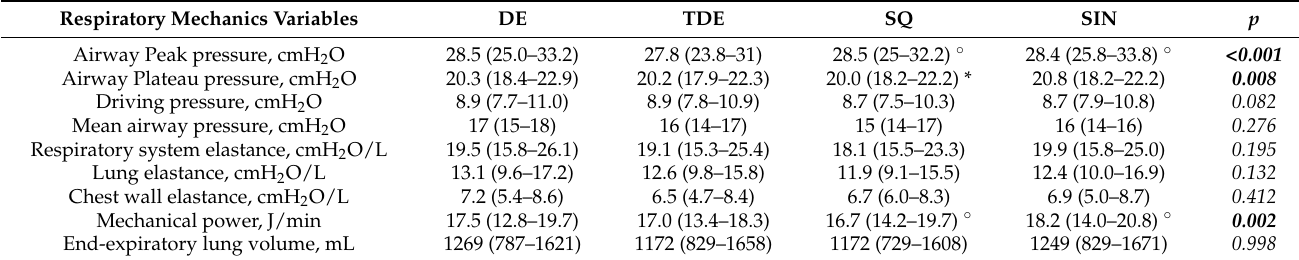
Table 3. Respiratory mechanics and end-expiratory lung volume according to flow waveforms.